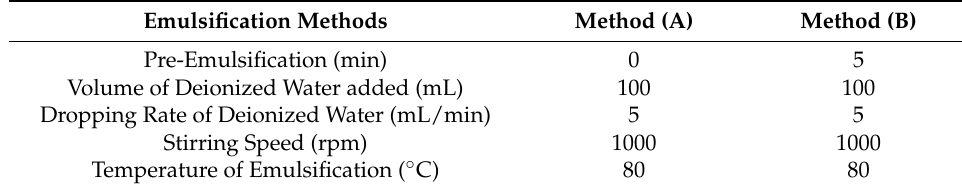
Table 2. Details of the two emulsification methods.